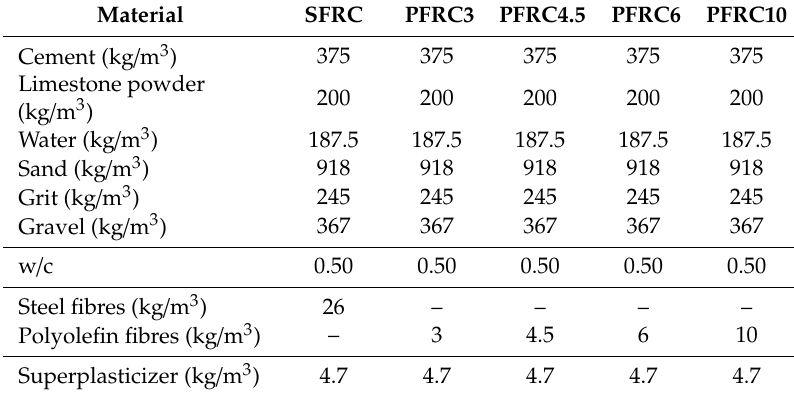
Table 1. Concrete mix